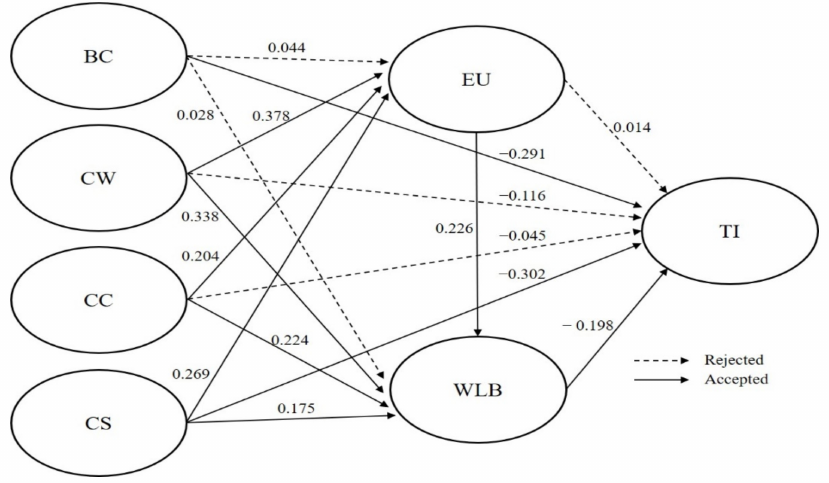
Figure 2. Result of structural equation